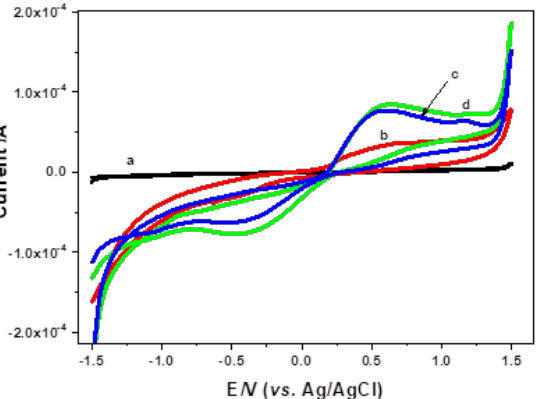
Figure 5. Cyclic voltammetric response for: (a) bare carbon paste electrode, (b) carbon paste electrode modified with AMB ligand, (c) carbon paste electrode modified with complex 1 and (d) carbon paste electrode modified with complex 2 . These used 5.0 mM K 3 [Fe(CN) 6 ]/K 4 [Fe(CN) 6 ], a potential scan rate of 50 mV s −1 and a potential range from +1.5 to −1.5 V (vs. Ag/AgCl).